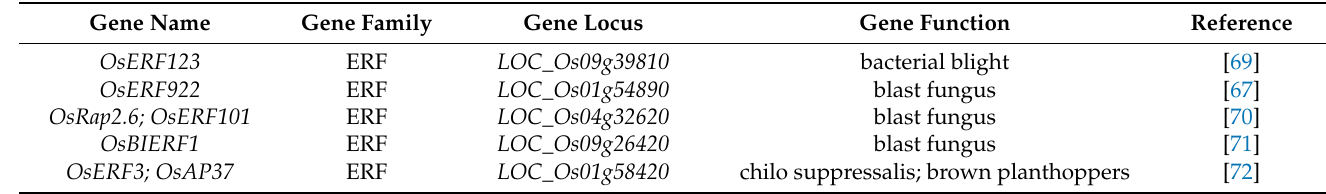
Table 10. Genes associated with biotic stress in